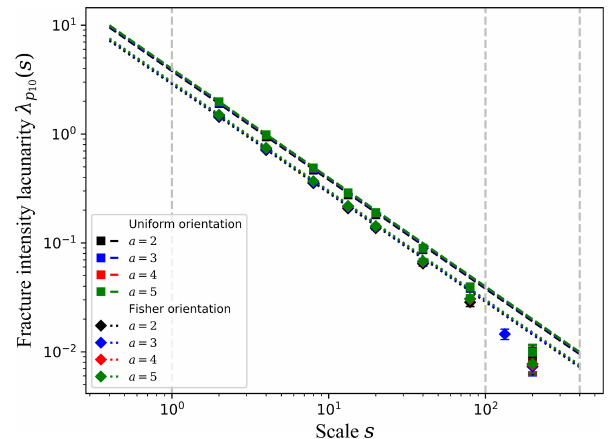
Figure 3. Fracture intensity lacunarity curves λ p with constant fracture size and bulk density p 32 = 0 .